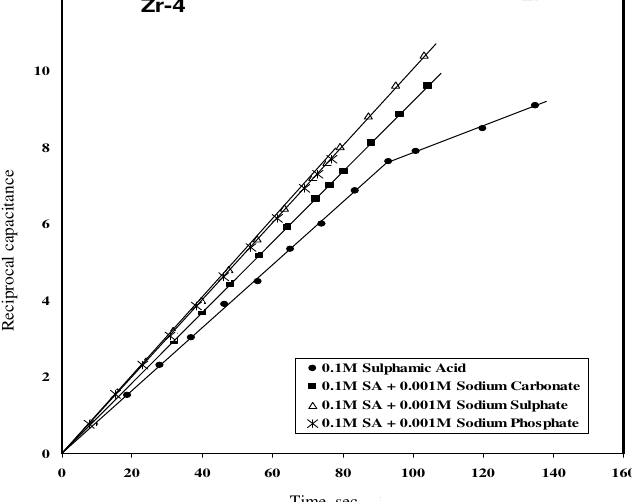
Figure 4. Plot of reciprocal capacitance as a function of time in anion impurity solution